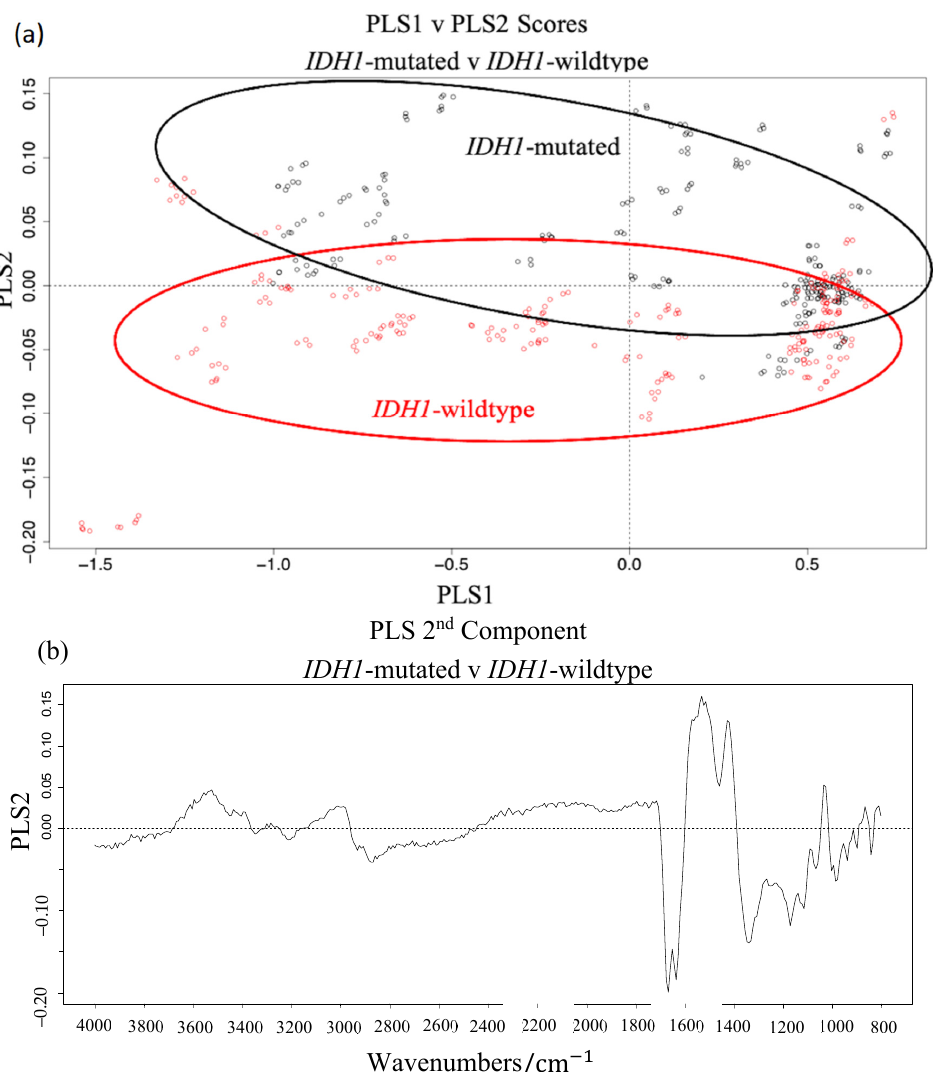
Figure 11. ( a ) the PLS scores plot between PLS1 and PLS2 for the IDH1 -mutated (black) and IDH1 -wildtype (red) data from the < 3 kDa serum filtrate (4000–800 cm − 1 ) dataset, and ( b ) the loadings for the 2 nd PLS component.